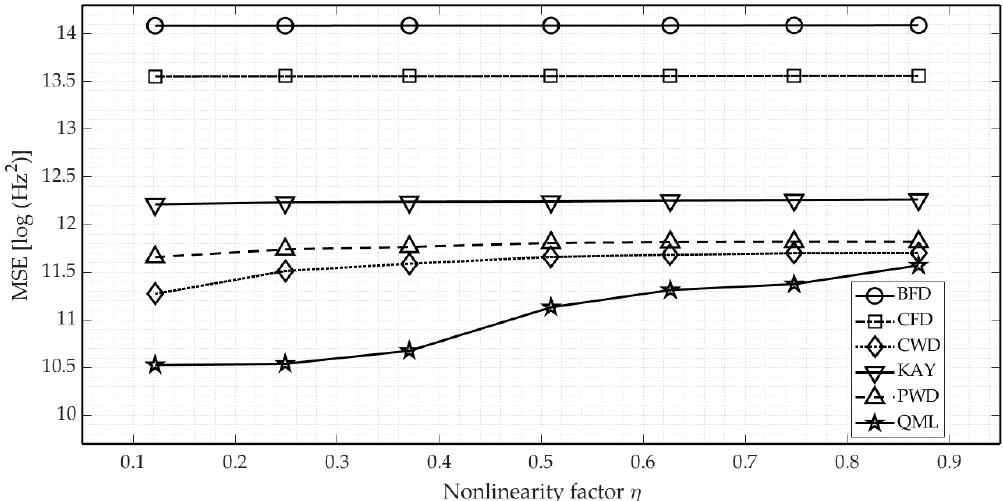
Figure 9. Estimation error in a function of the nonlinearity factor, for a fixed SNR value of 5 dB. In order to adjust the η value, the NLFM B waveform was used with fixed c 1 and c 2 coefficients while c 3 was chosen from range [ 1.07, 15 ] .